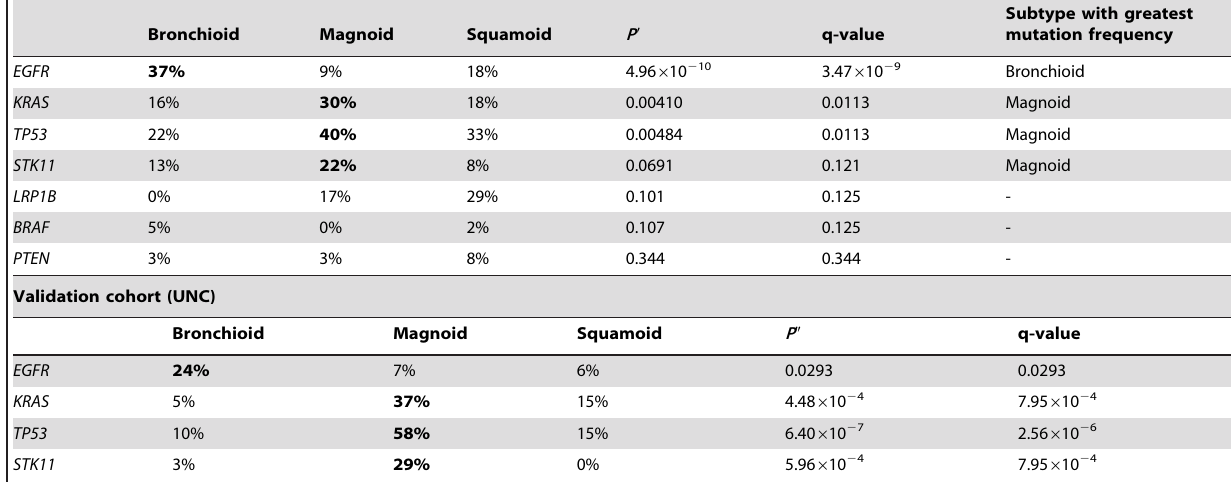
Discovery cohorts (Bhattacharjee et al., Chitale et al., Ding et al., Tomida et al.)